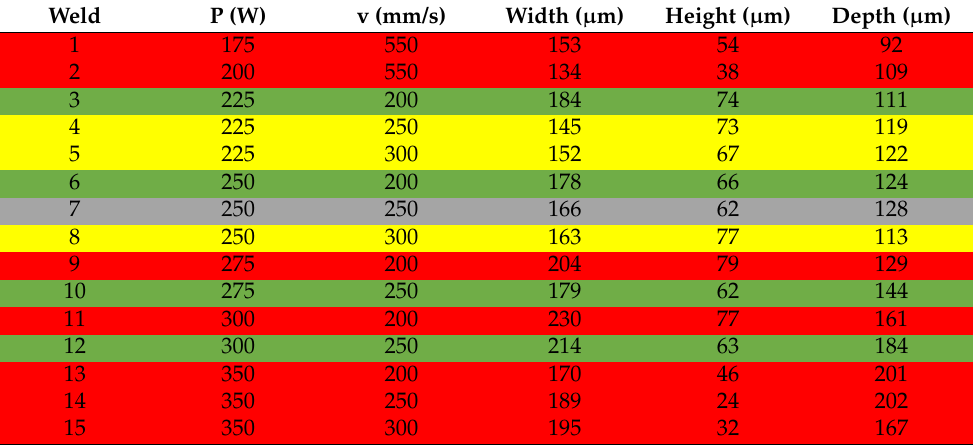
Table 9. Evaluation of selected welds based on metallographic analysis (red + grey—unsuitable, yellow—partially suitable, green—suitable).